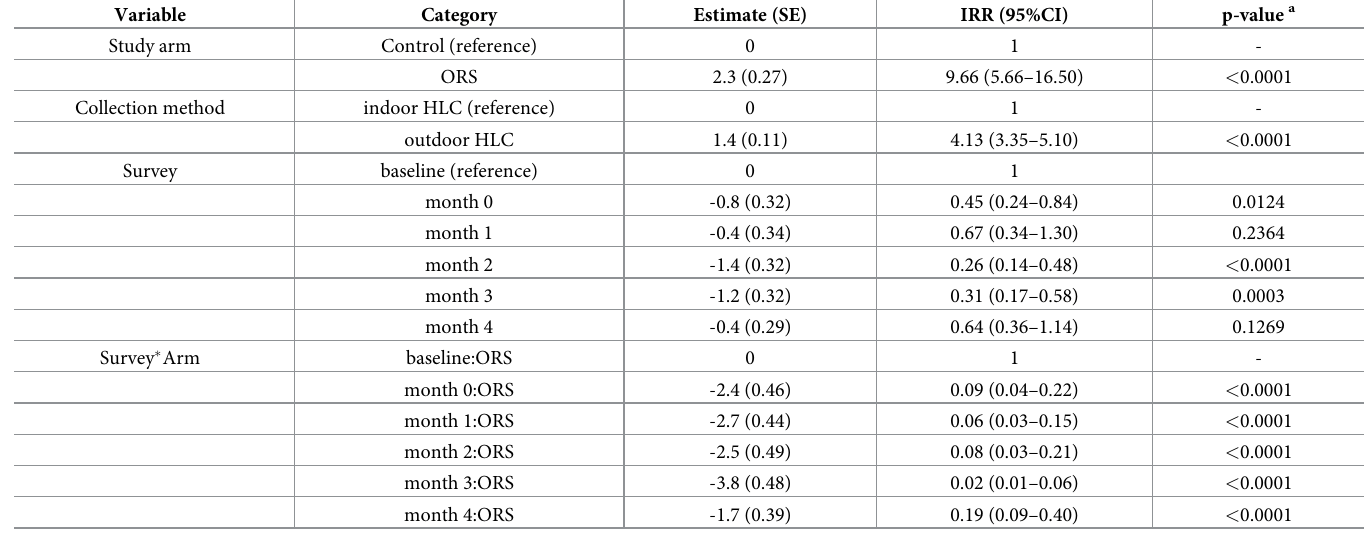
Table 3. Generalized linear mixed-effect model output for the multivariable analysis of the number of collected malaria vectors /person /night including location, visits and outdoor residual spraying as predictors.